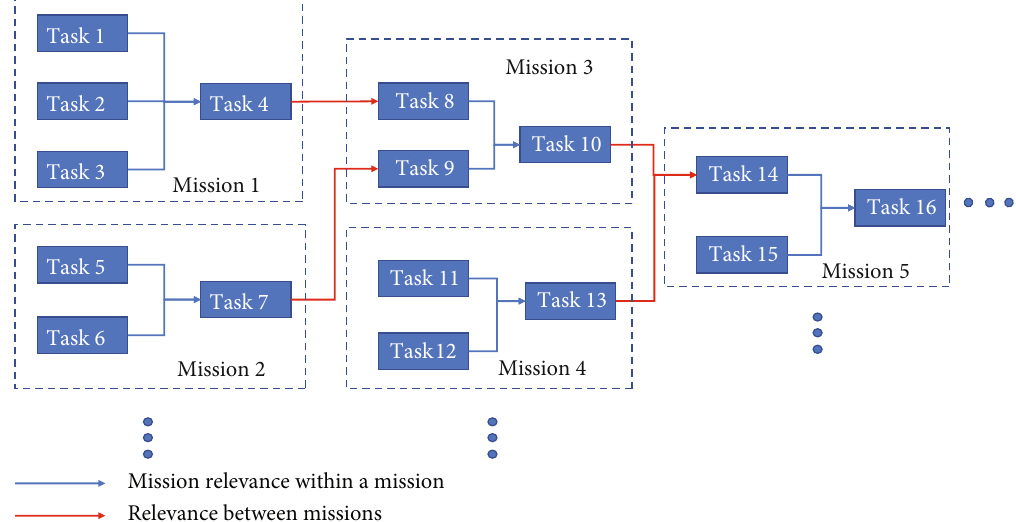
Figure 3: Associated task execution sequence fl owchart.